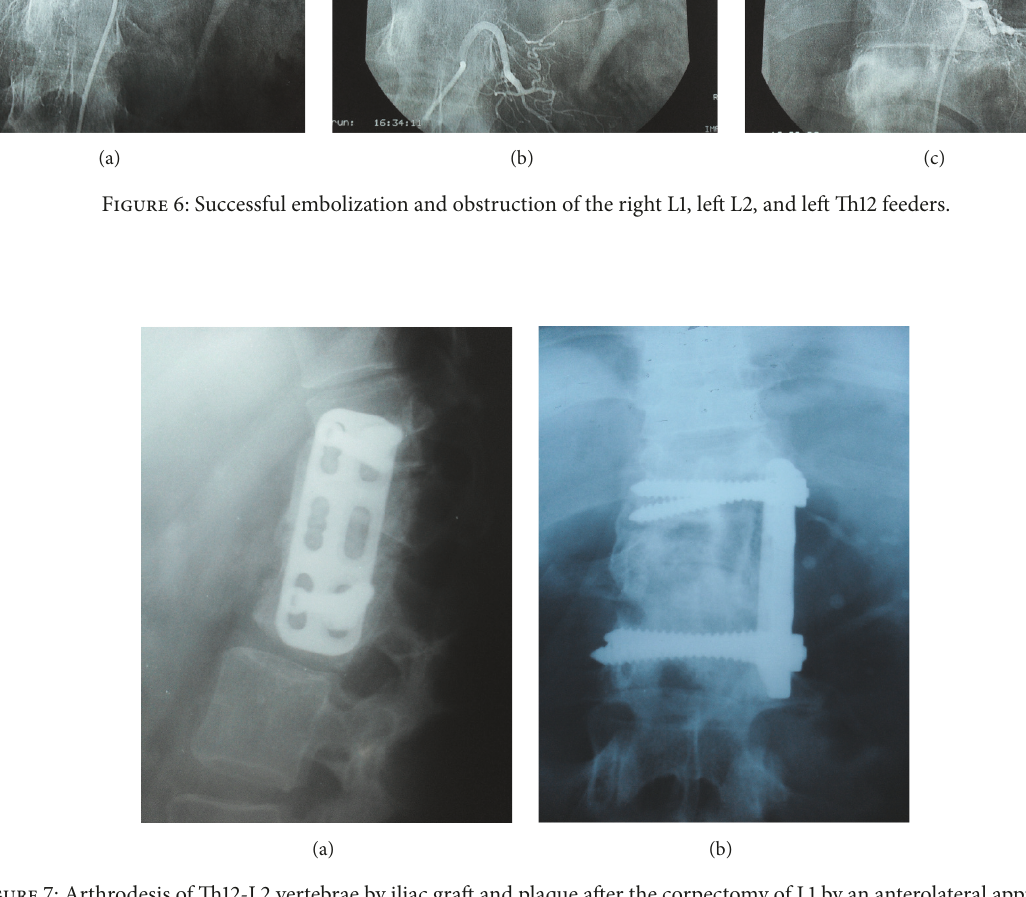
Figure 7: Arthrodesis of Th12-L2 vertebrae by iliac graft and plaque after the corpectomy of L1 by an anterolateral